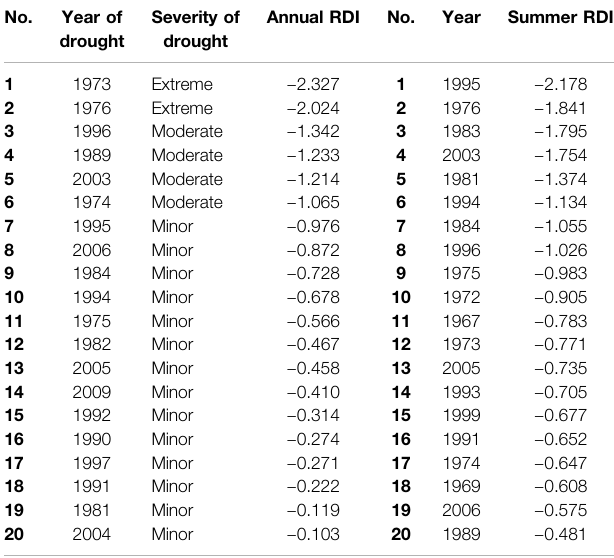
TABLE 2 | Most notable droughts in the Eden catchment from 1961 to 2012, based on (A) annual RDI; (B) summer RDI.